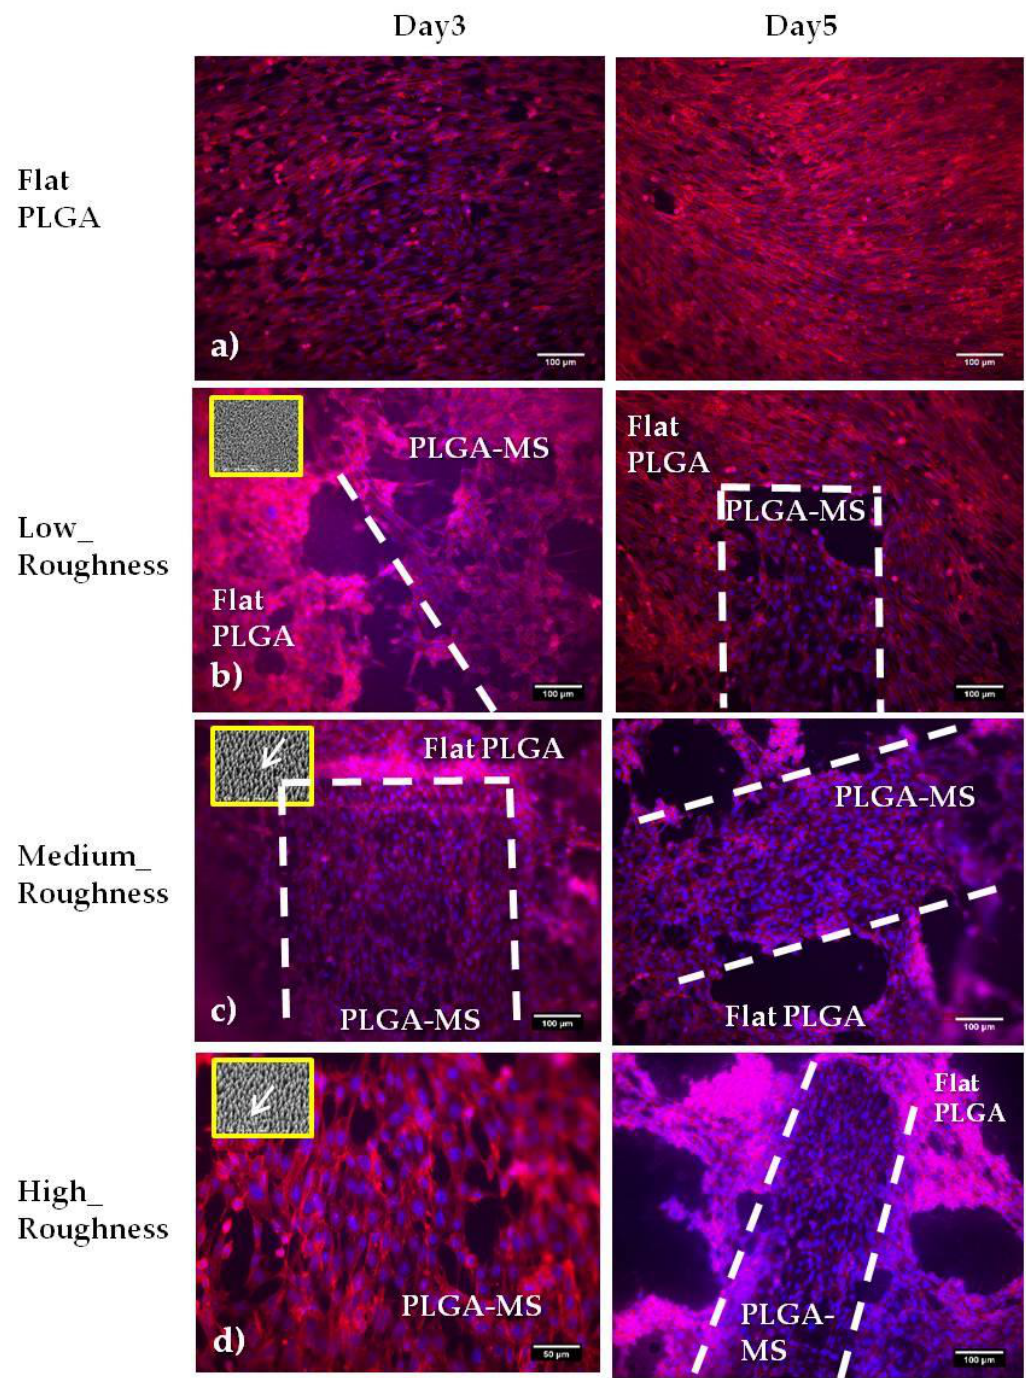
Figure 8. Fluorescent images of Schwann cells cultured on the ( a ) flat PLGA and PLGA-MS replicas ( b – d ) for 3 and 5 days. Each replica is defined by low ( b ), medium ( c ), and high ( d ) roughness. The cytoskeleton of the cells is visualized with red color (Alexa Fluor ® 568 Phalloidin). The white interrupted lines represent the PLGA-MS area, and thus the area with the spikes. It should be noted that for this specific study using the actin/DAPI assay, the PLGA-MS replicas (spike’s area) were 0.3–0.5 mm (width) and 1.5 mm (length). The inset SEM images on the left side, indicated by the yellow box, show the topography of the PLGA-MS replicas, and the white arrows represent the directionality of the spikes.